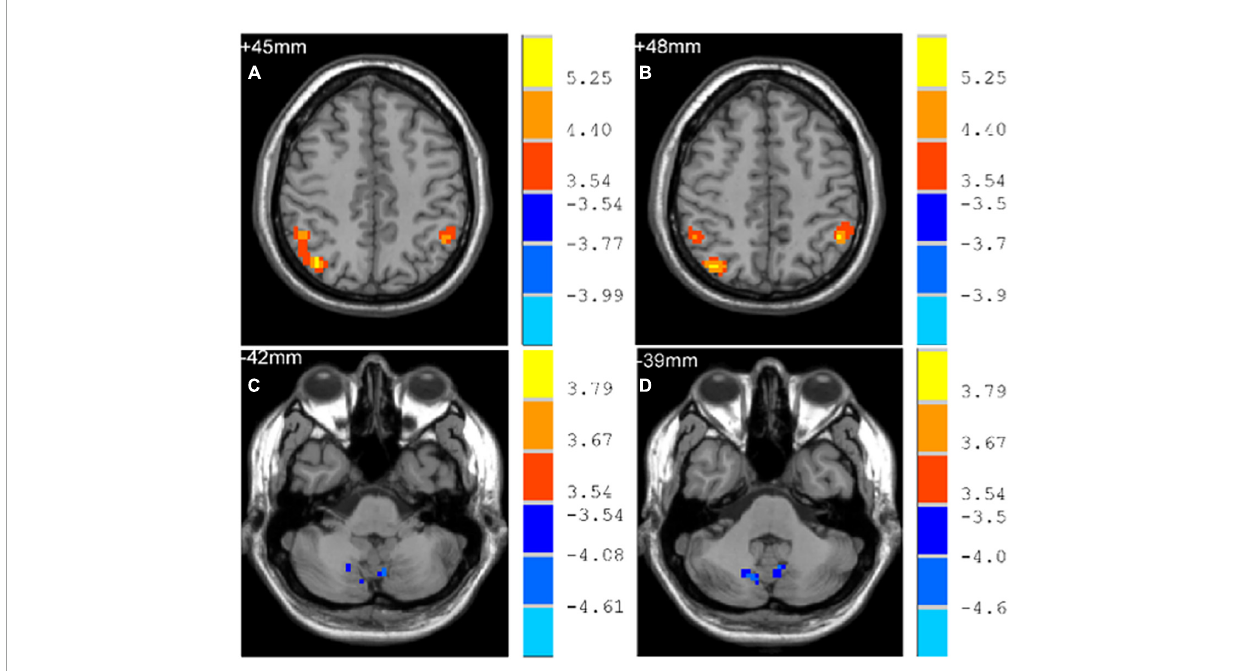
FIGURE4 Brain regions with altered intra-networks functional connectivity in LOPD. (A) Right angular gyrus. (B) Left inferior parietal gyrus. (C) Lobule VIII of left cerebellar hemisphere. (D) Lobule VIII of right cerebellar hemisphere. Yellow and red represent brain regions with significantly increased intra-networks functional connectivity in LOPD. Blue represents brain regions with significantly decreased intra-networks functional connectivity in LOPD. Two-sample t -tests results are presented ( p < 0.05, AlphaSim